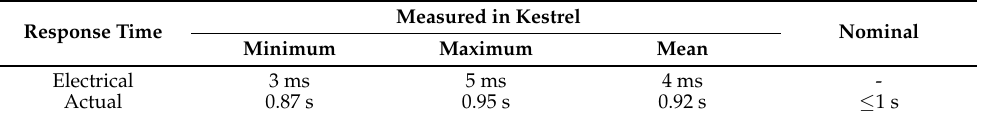
Table 4. Response times of the MQ-135 gas